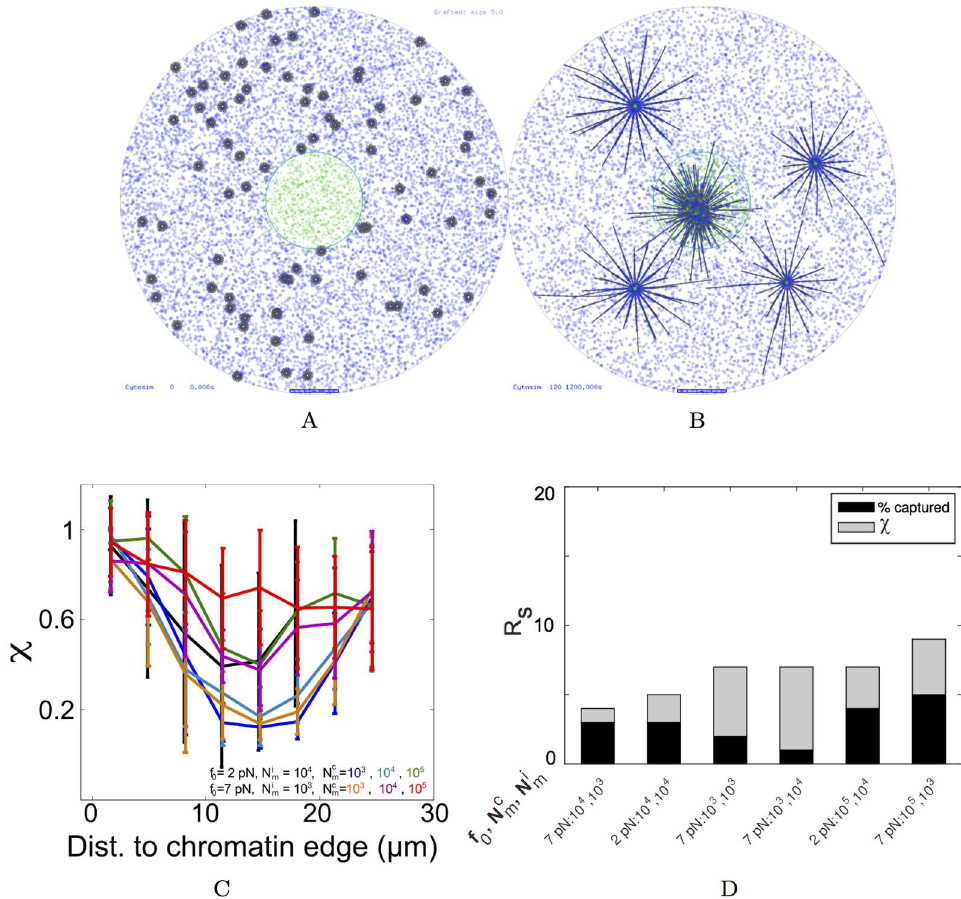
Fig 6. Combining immobilized and clustering motors. Simulationoutputs of MTOCs (grey) motility in the ¼ 10 4 , f 0 = 7 pN) with presence of a combination of diffusible tetrameric minus-ended motor complexes ( N c m ¼ 10 3 motors/oocyte, f 0 = 7 pN) at (A) t = 0 and (B) chromatin-centered gradient of immobilized motors ( N i m t = 20 minutes. (C) The χ values of aster movement resulting from increasingdensities of weak ( f 0 = 2 pN) and ¼ 10 3 to 10 5 motors/oocyte) in the presence of a gradient of strong ( f 0 = 7 pN) clustering motors ( N c m ¼ 10 4 for f 0 = 2 pN and N i ¼ 10 3 for f 0 = 7 pN). (D) The sum immobilized motors with the same f 0 values ( N i m m rank ( R s ) based on the sum of square errors ( (cid:15) ) from χ distributions (grey) and % MTOCs captured in 20 minutes (black) from experiment are plotted in an ascendingorder, with the parametersof the density of immobilized motors ( N i ) and diffusible motor complexes ( N c ) plotted, assuming the f 0 is constant for both. m m